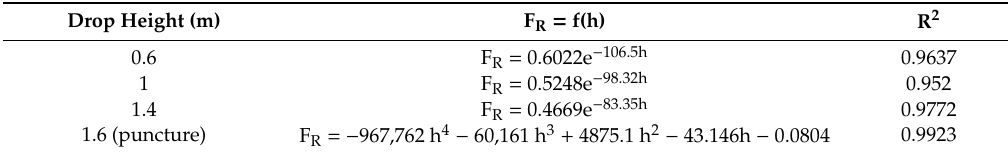
Table 3. Correlation between the impact force F R and the height h for the drop hammer weight of 90 kg. Drop Height